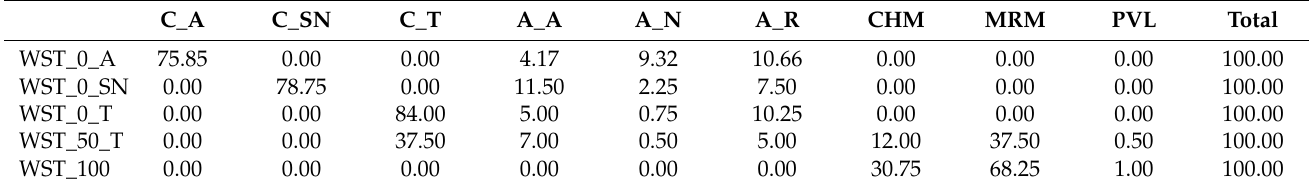
Table 7. Composition (wt %) of the raw materials and wastes of the designed crude blends.